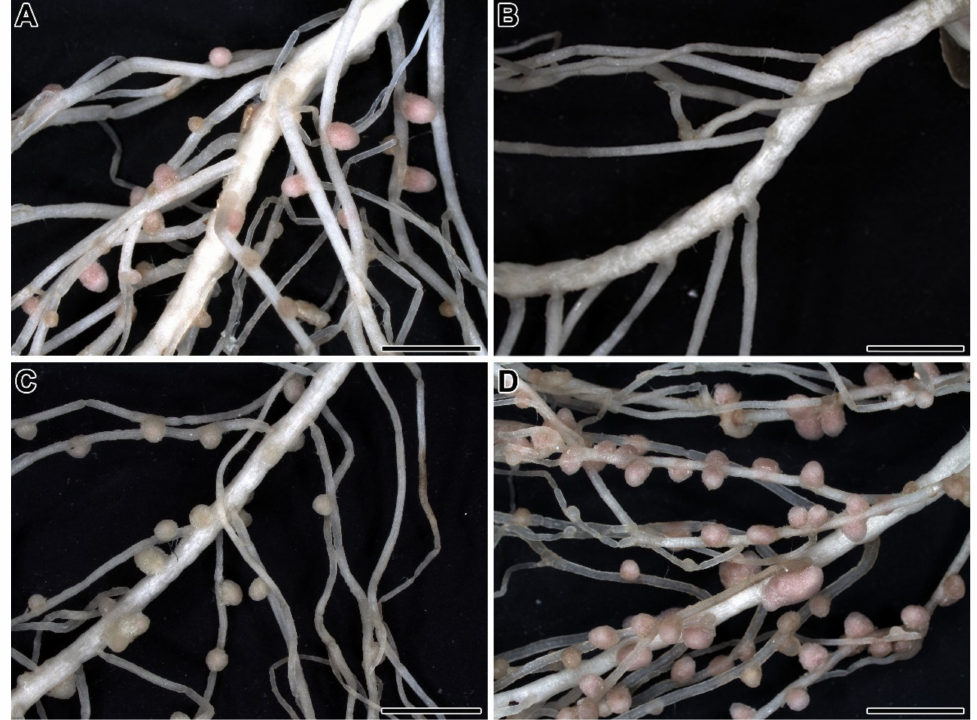
Figure 1. Phenotypes of root systems of wild-type pea and mutants 3 weeks after inoculation with Rhizobium leguminosarum bv. viciae strain 3841. ( A ) Wild-type Frisson. ( B ) Nod − mutant SGENod − -3 ( Pssym35 ). ( C ) Fix − mutant SGEFix − -3 ( Pssym26 ). ( D ) Nod ++ mutant P64 ( Pssym28 ). Bars = 10